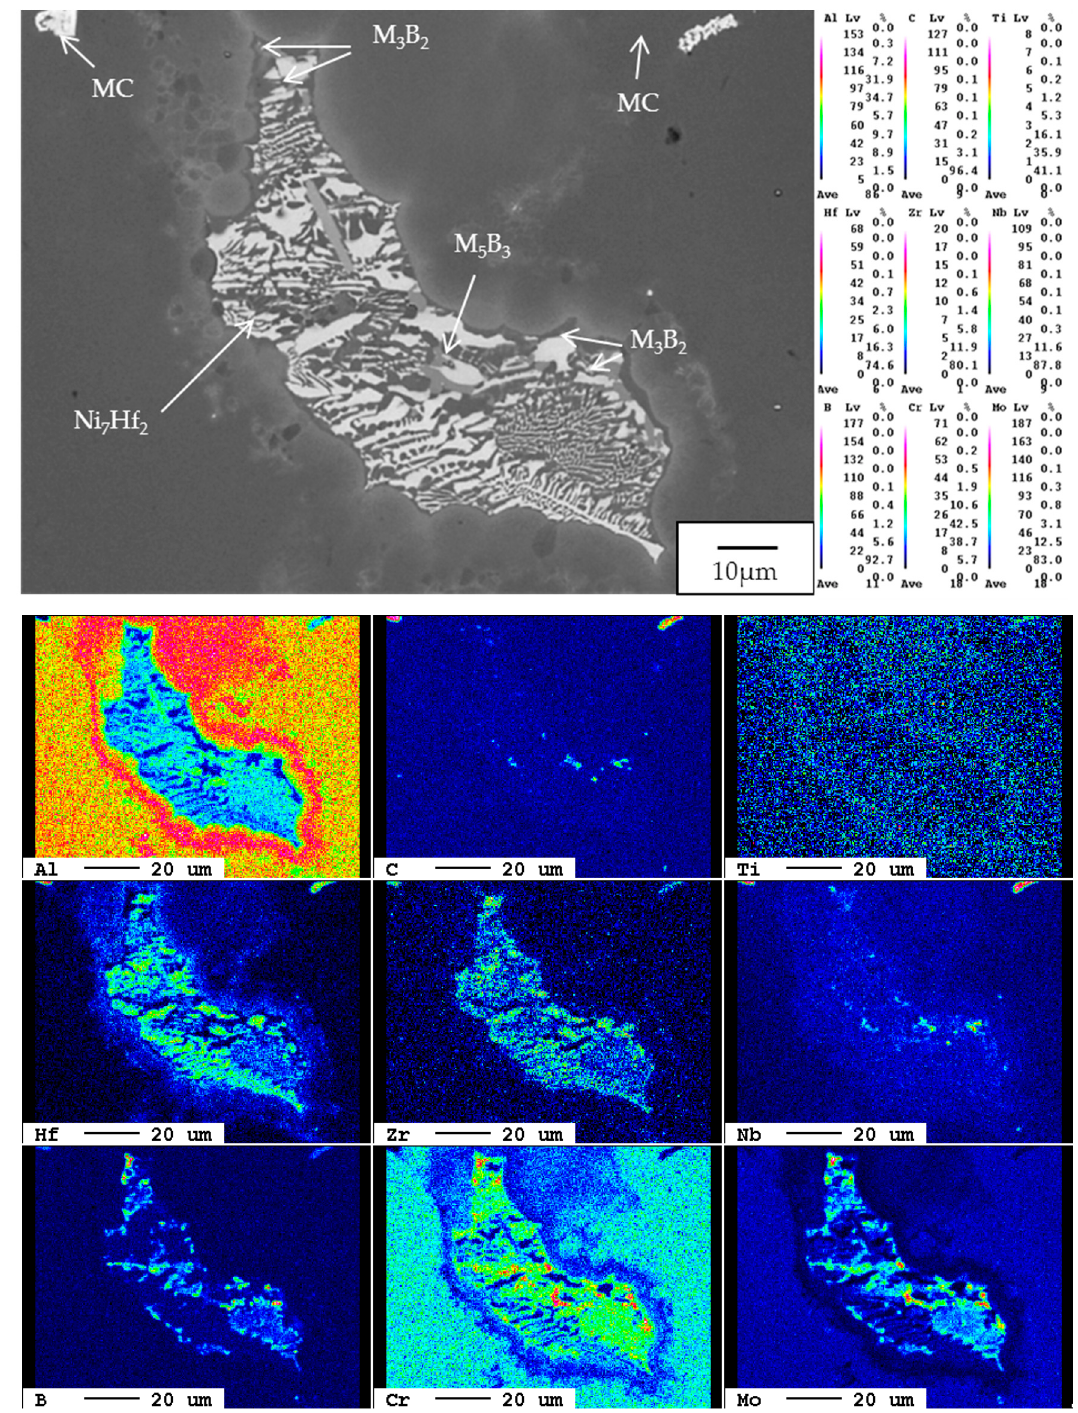
Figure 3. BSE image of the interdendrtic product and the associated EPMA maps of the Al, C, Ti, Hf, Zr, Nb, B, Cr, Mo elements in the microconstituent.